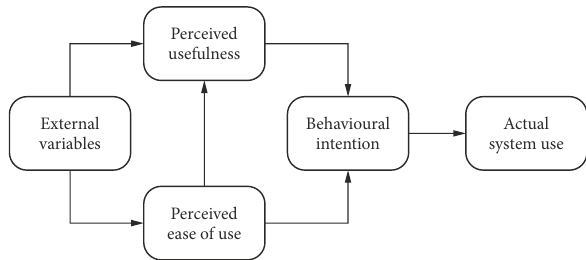
Behavioural intention